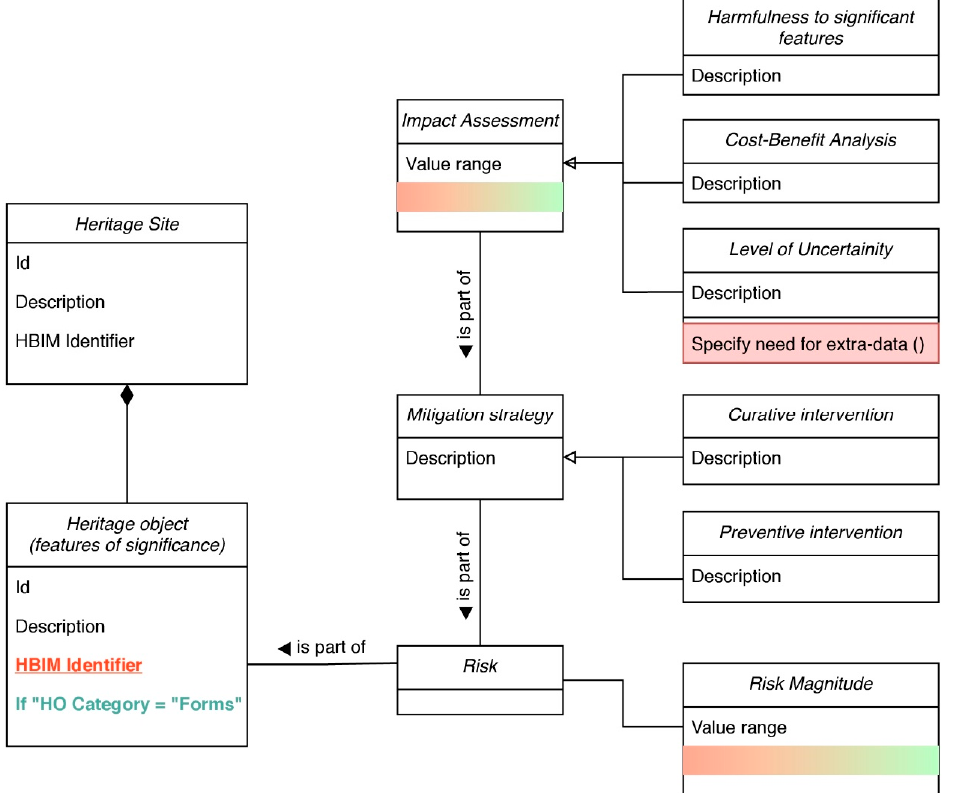
Figure 10. Elaboration and assessment of strategies to mitigate the e ff ects of the risk. A risk is associated with several potential solutions (curative and preventive), the impact of which has to be assessed based on a cost–benefit analysis and relativized by the level of uncertainty of the data used for the assessment. The latter is particularly useful, since it indicates the need for the acquisition of additional information to decision-makers.